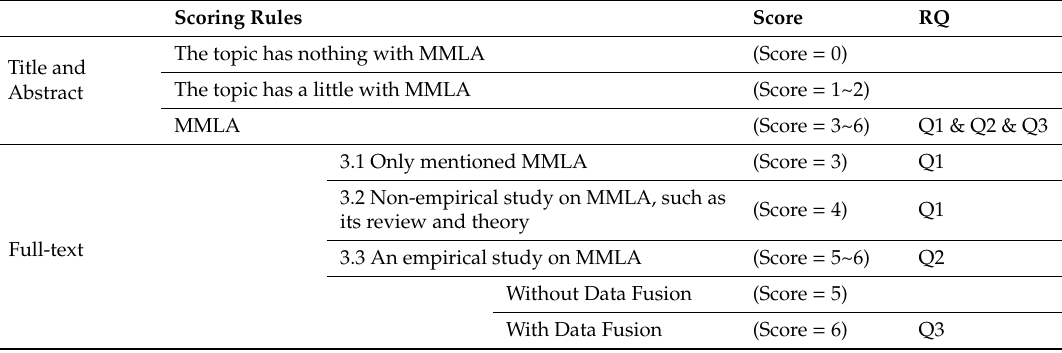
Table 2. Scoring rules.